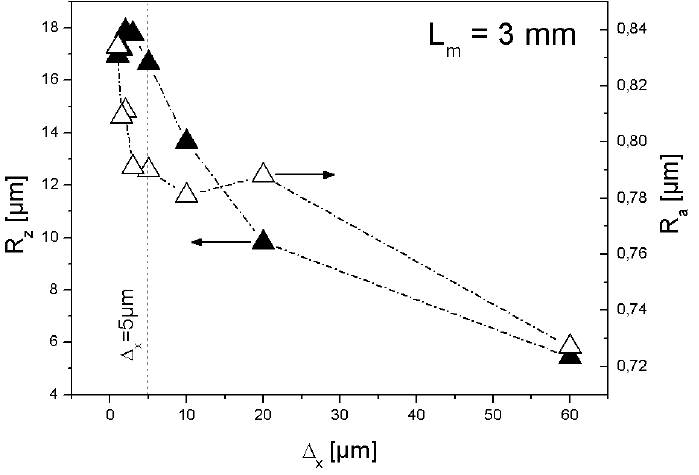
Figure 6. Roughness of the SMC topography as a function of resolution